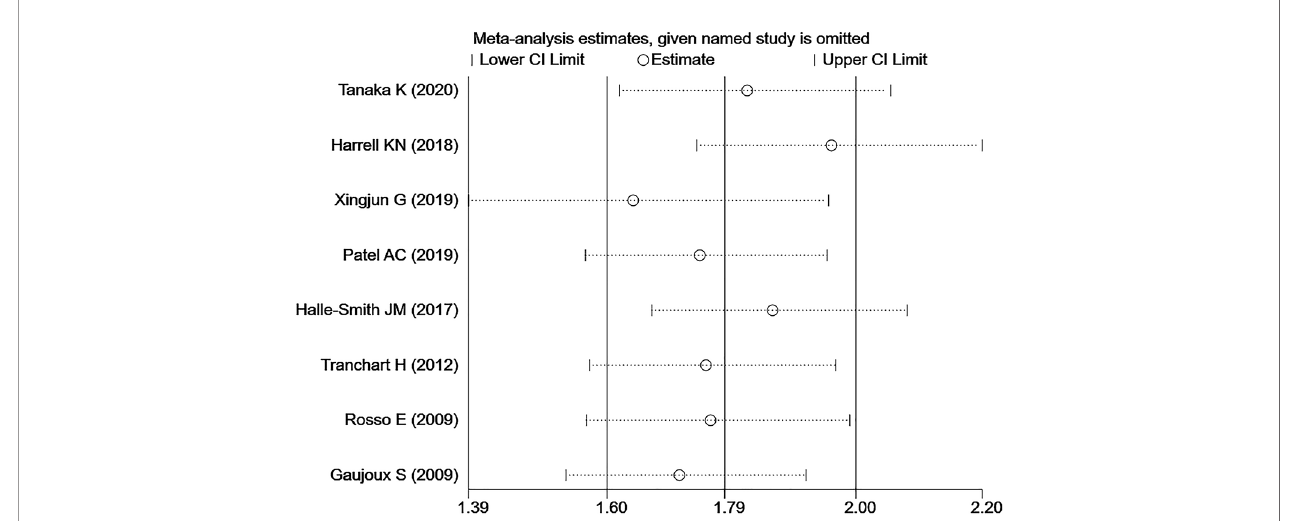
FIGURE 5 | Sensitivity analysis of the association Association Between FP and POPF.